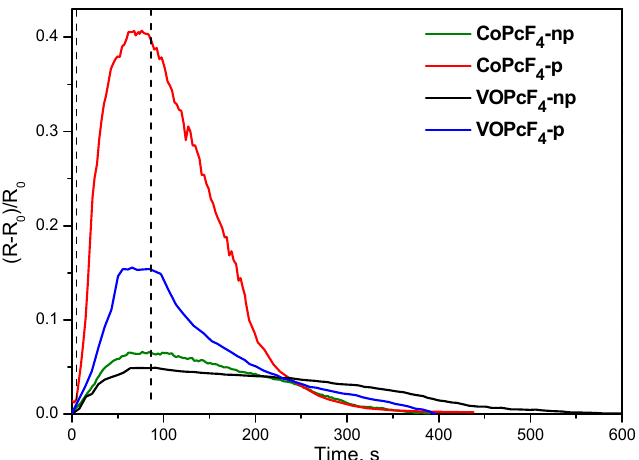
Figure 7. Sensor response of MPcF 4 -p and MPcF 4 -np films (M = Co, VO) to ammonia (5 ppm), measured at room temperature. Table 1. Limits of ammonia detection (LOD), response and recovery times of MPcF 4 -p and MPcF 4 - np films.